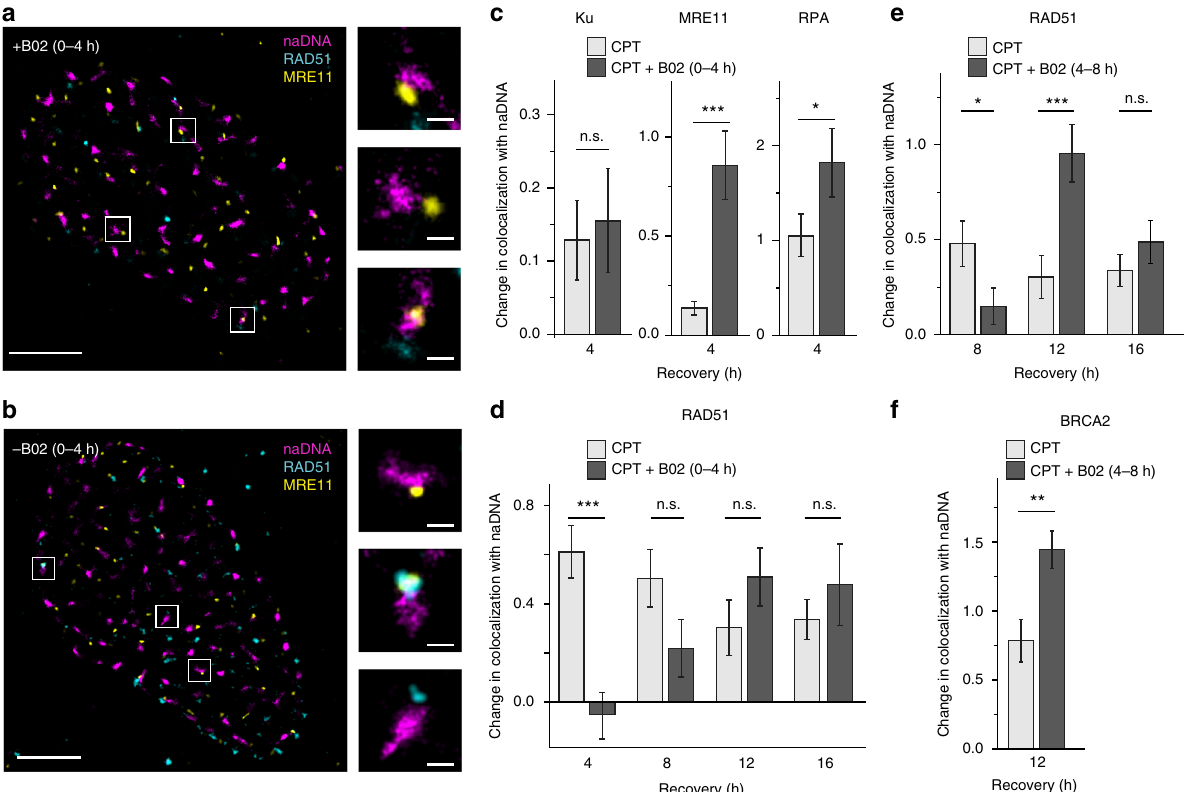
Fig. 4 The RAD51 inhibitor B02 prolongs resection and antagonizes ssDNA/RAD51 nucleo fi lament formation and function. a , b Representative SR images of two nuclei immunolabeled for naDNA (magenta), RAD51 (cyan), and MRE11 (yellow) 4 h after release from CPT damage. The cell in a was further treated with B02 during the 4 h of recovery from CPT compared to the control cell shown in b . Representative multicolor foci shown. Whole-cell image scale bars = 3 μ m, zoomed sections = 250 nm. c Quanti fi cation of Ku, MRE11, and RPA association with repair foci in cells treated with B02 to inhibit nucleo fi lament formation during the fi rst 4 h following 1-h CPT treatment. d Quanti fi cation of RAD51 association with repair foci in cells treated with B02 to inhibit nucleo fi lament formation during the fi rst 4 h following 1 h CPT treatment. e Quanti fi cation of RAD51 association with repair foci in cells treated with B02 to inhibit nucleo fi lament function beginning 4 h into recovery from CPT treatment for a further 4 h. f Quanti fi cation of BRCA2 association with repair foci in cells treated with B02 to inhibit nucleo fi lament function beginning 4 h into recovery from CPT treatment for a further 4 h. For complete N values, see Supplementary Table 1. Error bars represent mean ± s.e.m. Student ’ s t test for signi fi cance between CPT and CPT + B02. n.s. p > 0.05, * p < 0.05, ** p < 0.01, *** p <